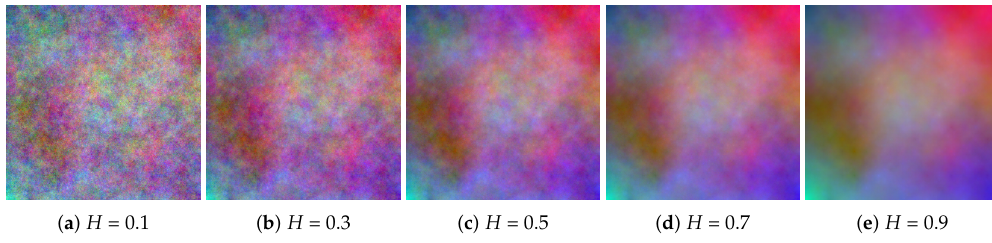
Figure 1. Color fractal